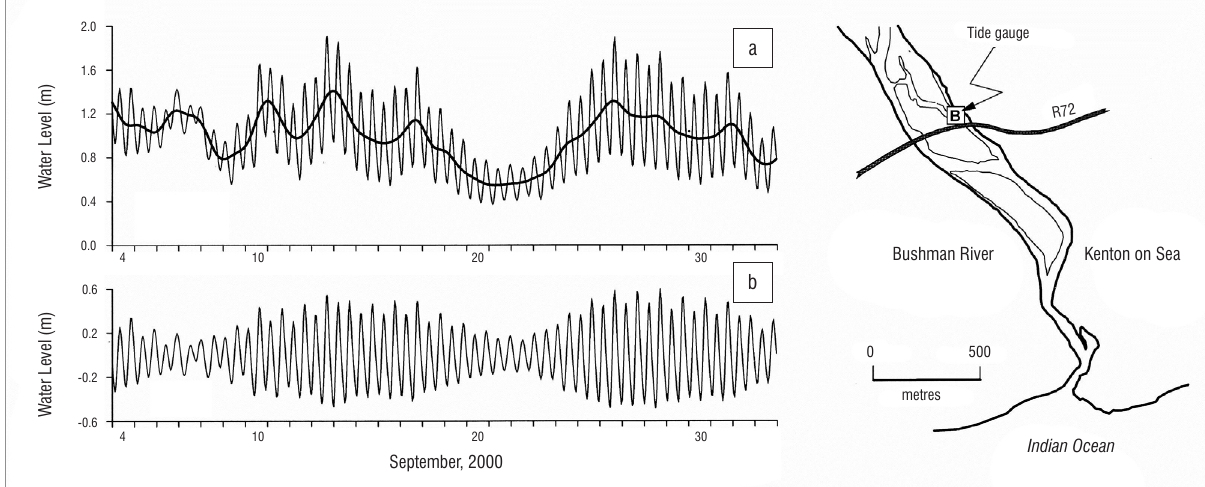
Figure 8: Water level variability in the Bushmans Estuary. The upper figure (a) shows the measured variability, while the lower figure (b) shows the same variability with the subtidal fluctuations